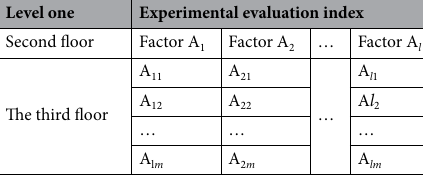
Table 6. Data structure of orthogonal